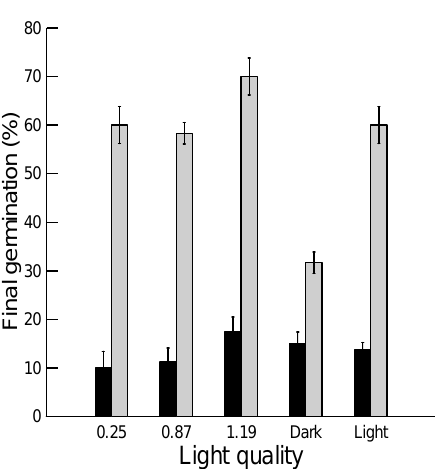
Figure 5. Effect of different light qualities on final germination percentage (mean ± SE) of dehusked-demembraned (dark bars) and dehusked-membraned (light bars) grains of Brachypodium hybridum.